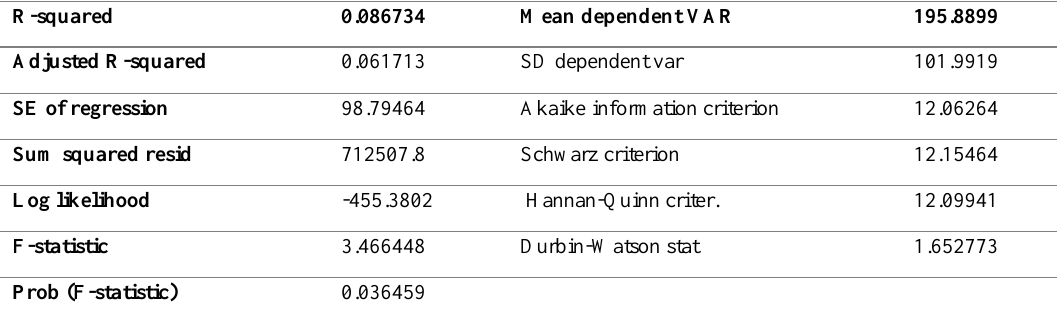
Table 3: Autocorrelation Test